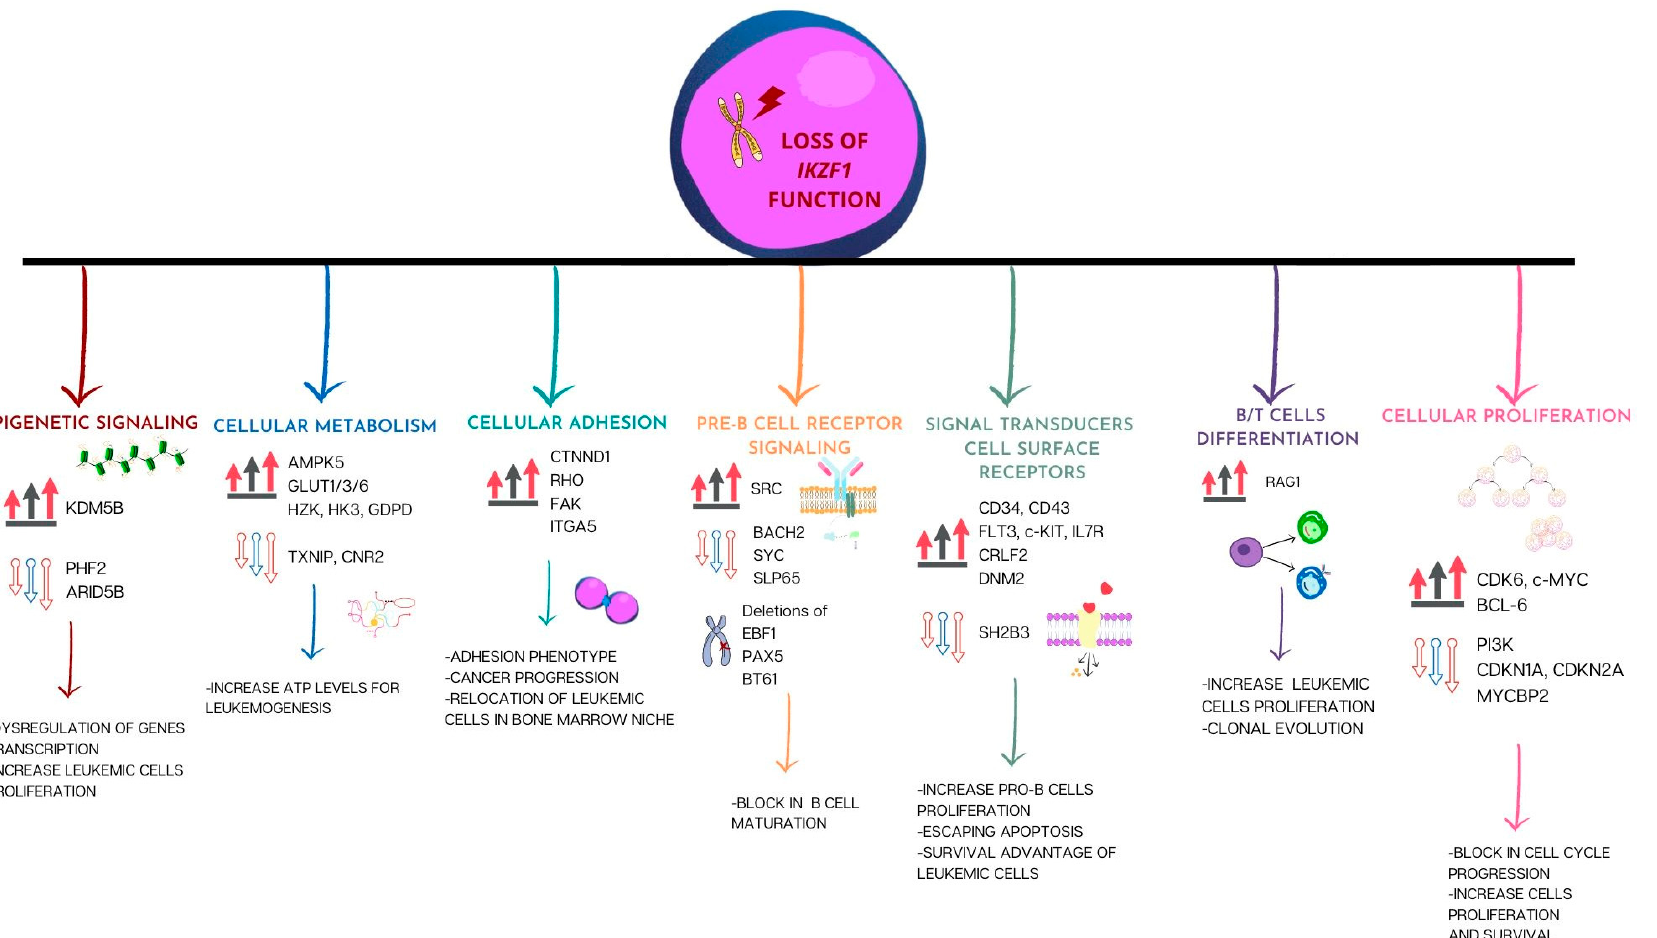
Figure 3. Graphical representation of the altered pathways (epigenetic signaling [100–104]; cellular metabolism [105]; cellular adhesion [106,107]; pre-B-cell receptor signaling [73,85,108,109]; signal transducer cell surface receptors [110–114]; B/T-cell differentiation [115]; cellular proliferation [110,116–121]) due to loss of IKZF1 function in B-cell acute lymphoblastic leukemia.